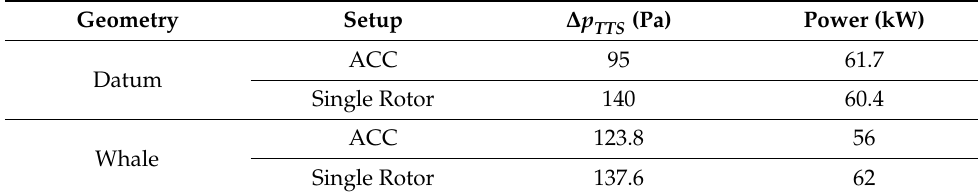
Table 1. Validation of CFD results.